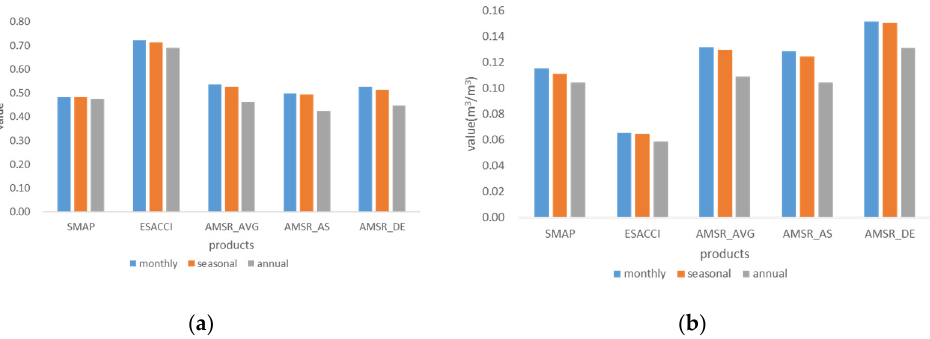
Figure 3. Overall performance of five products at different time scales. ( a ) performance of R, p -value < 0.0001; ( b ) performance of ubRMSE.